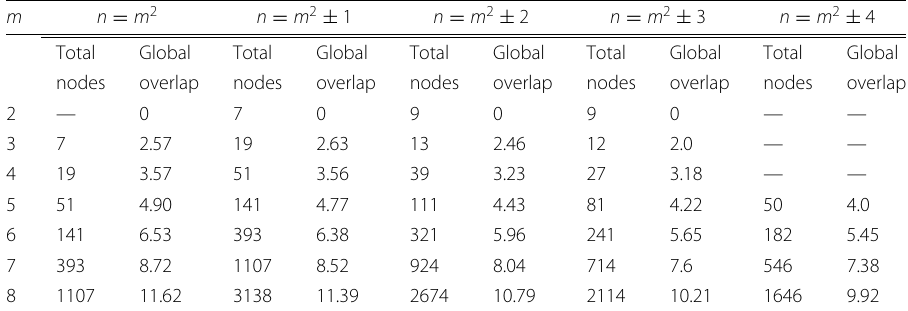
As in Table 1 the parameters MDenV ( m ) and MDenCl are calculated for graphs without head node. Number of nodes for the graphs G ( DDPF ( n , m )) and Global overlapping does not coincidence with graphs for progenitor DDPF ( m 2 ) . Total cliques numbers are the almost the same (2 m instead of 2 m − 2) and the topological characteristics such as clustering coefficients, global efficiency,characteristic path length and graph density (exception is the nodes degrees distribution) for networks of Table 3 are practically indistinguishable from accordance characteristics in Table